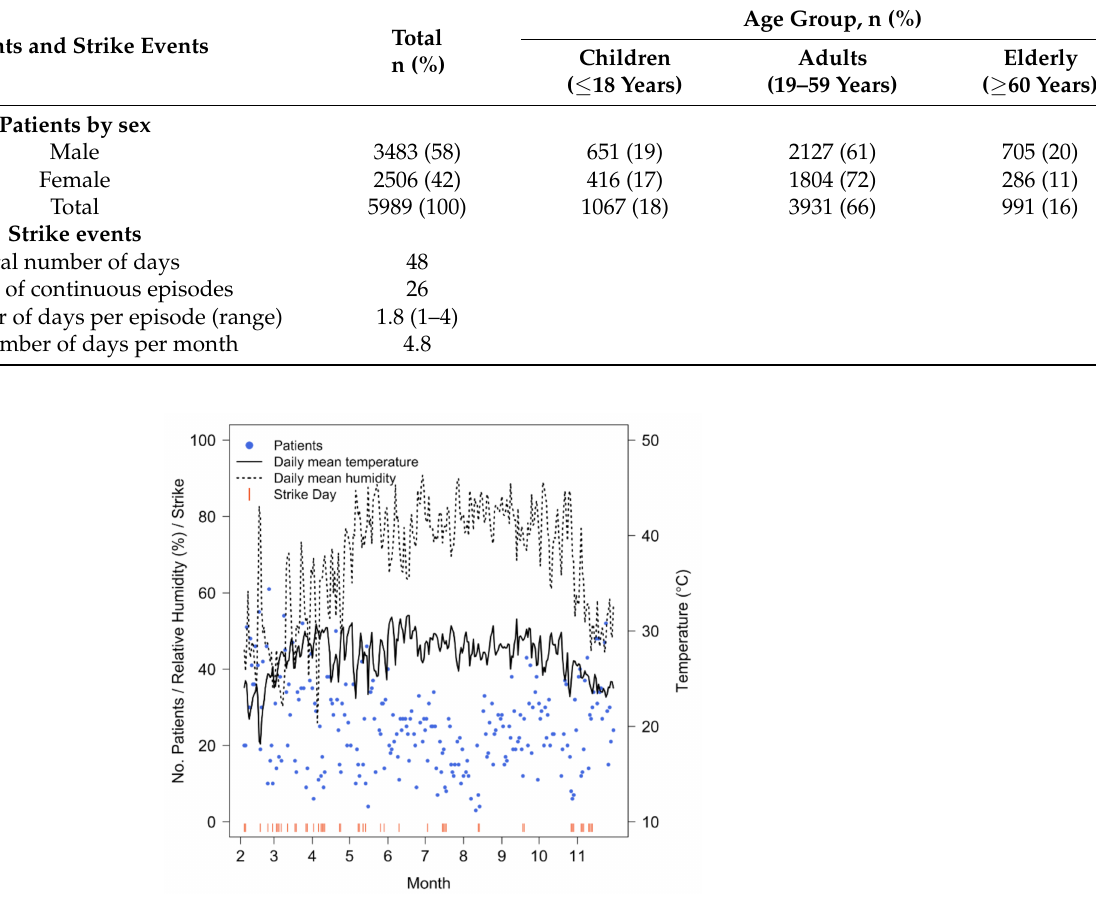
Table 1. Asthma visits treated with nebulized medication at the National Asthma Centre, Mohakhali, Dhaka, Bangladesh and strike events occurring in the vicinity, February–November 2013.